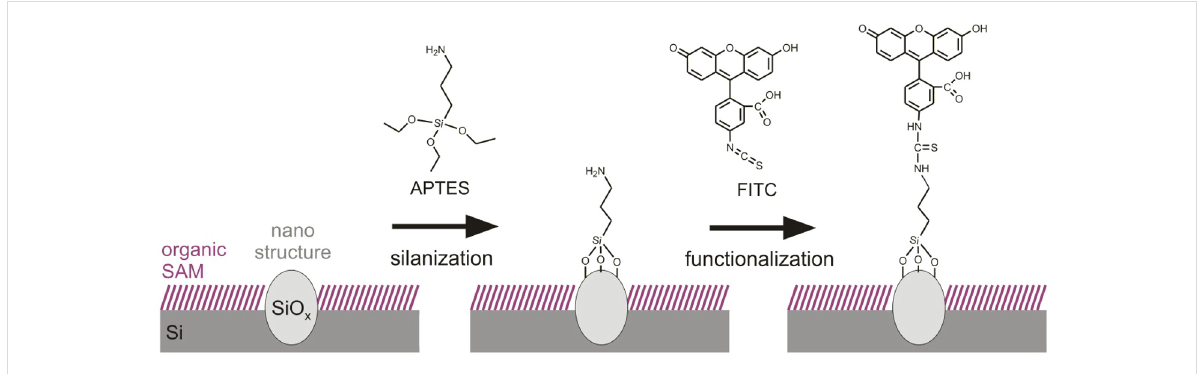
Figure 1: Schematic route for covalent binding of FITC to a silicon oxide nanostructure on alkyl-terminated silicon. After local anodic oxidation, a layer of APTES molecules is bound to the silicon oxide as linker. In a second step, FITC is bound to the amino-functionalized oxide structure.